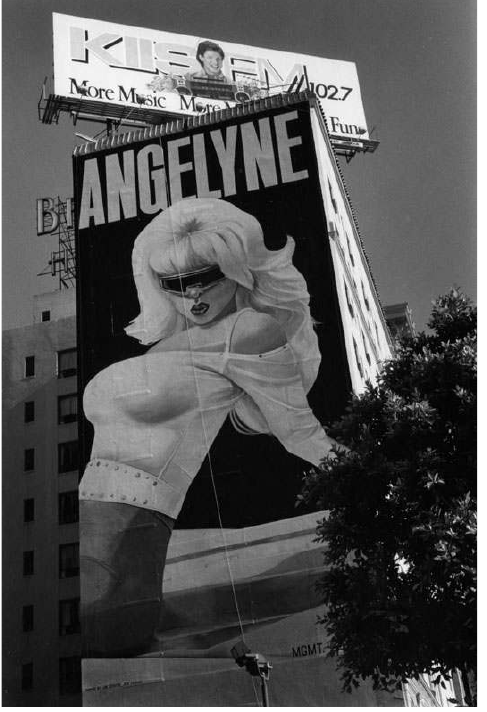
Source: https://csl.primo.exlibrisgroup.com/view/delivery/01CSL_INST/12136452470005115